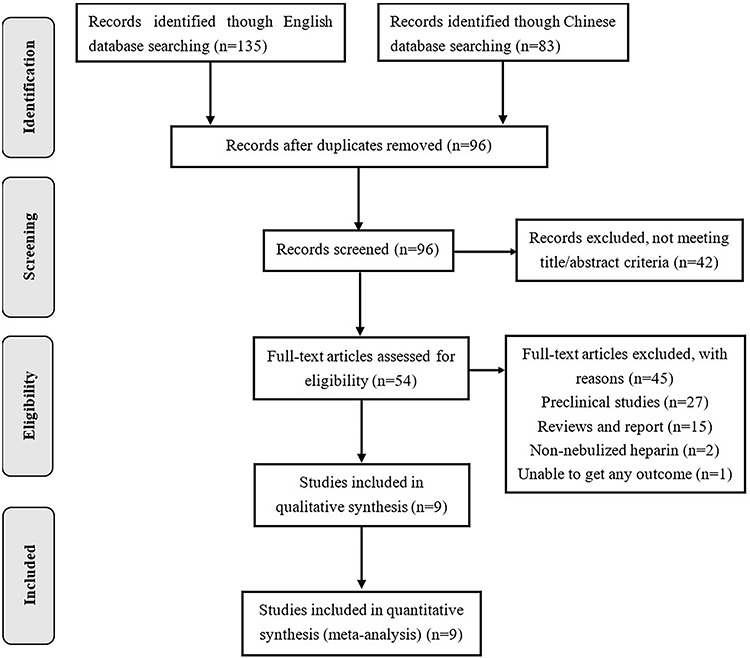
Preferred Reporting Items for Systematic reviews and Meta-Analyses (PRISMA) flow chart summarizing the results of the screening process and final article selections